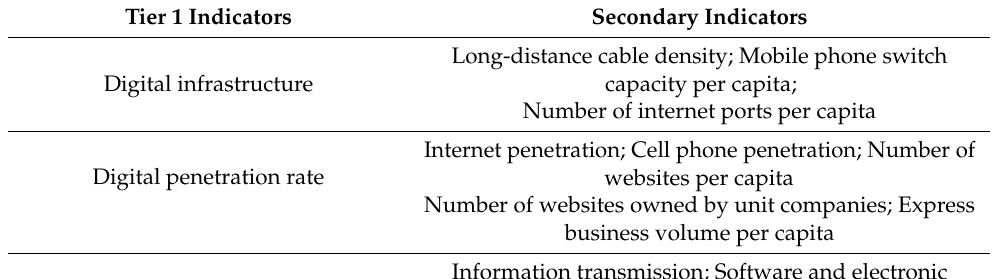
Table 2. Digital Economy Development